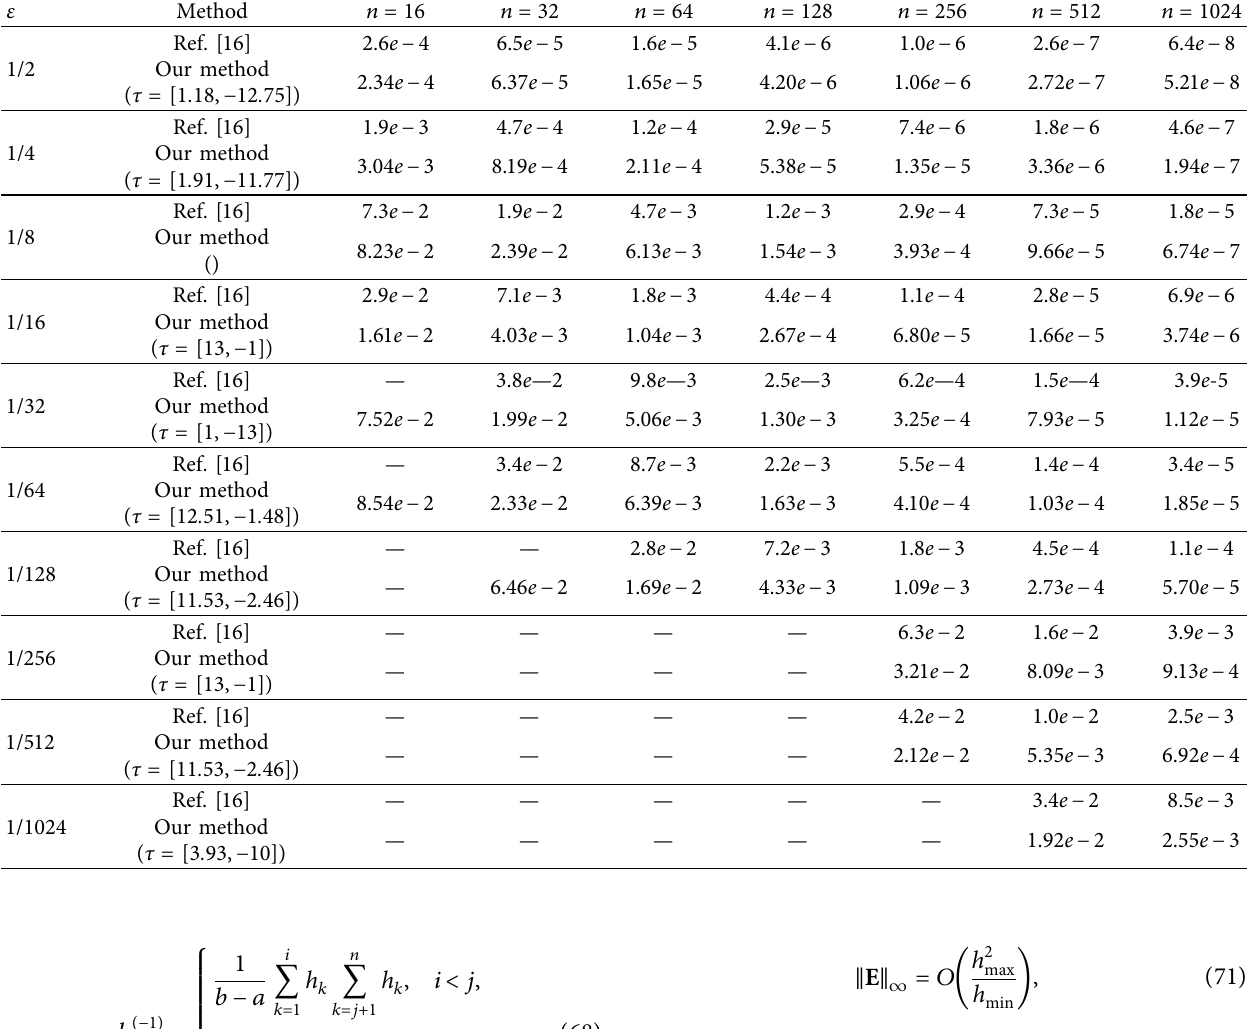
and root mean square error for problem ∞